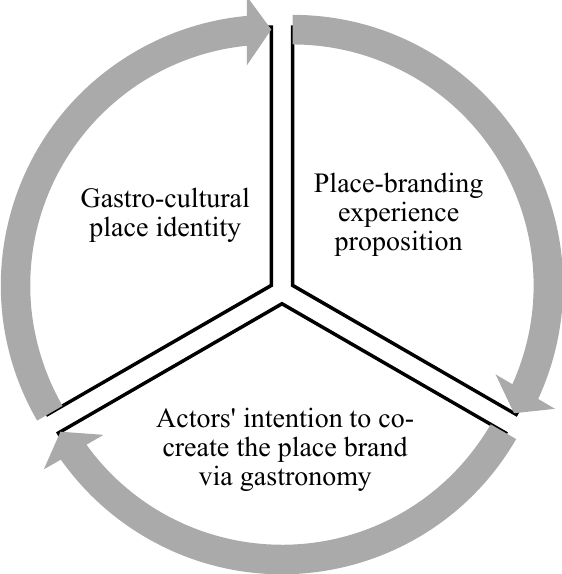
Figure 1. Initial conceptual model.